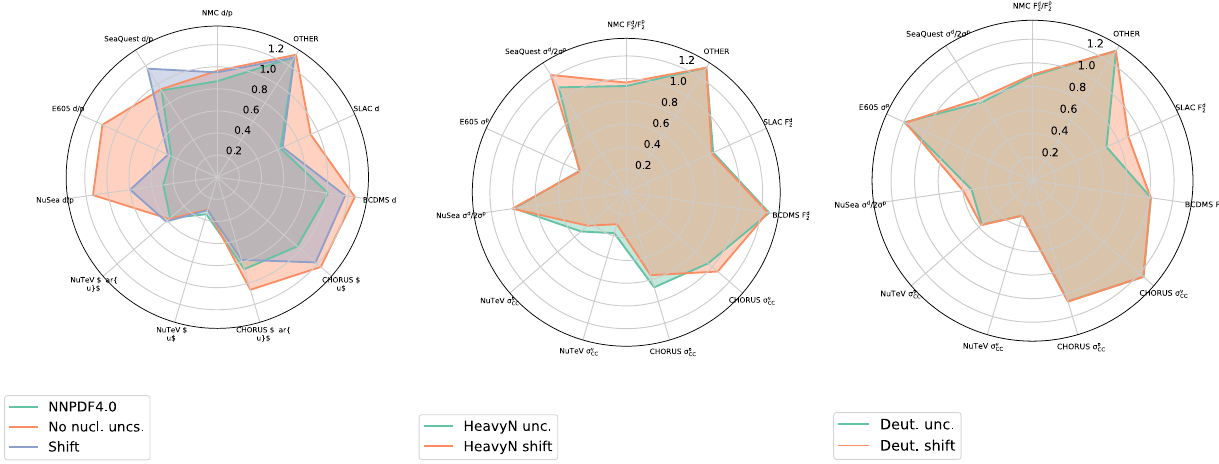
Fig. 53 The values of the χ 2 for individual datasets for the PDF fits listed in Table 31. The datasets unaffected by nuclear corrections are grouped in the “other” category